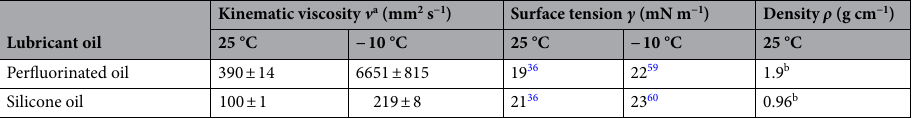
Table 2. Physical properties of lubricant oils at room temperature (25 °C) and − 10 °C. a Kinematic viscosity temperature dependence determined in accordance with ASTM D314-17. b Data from